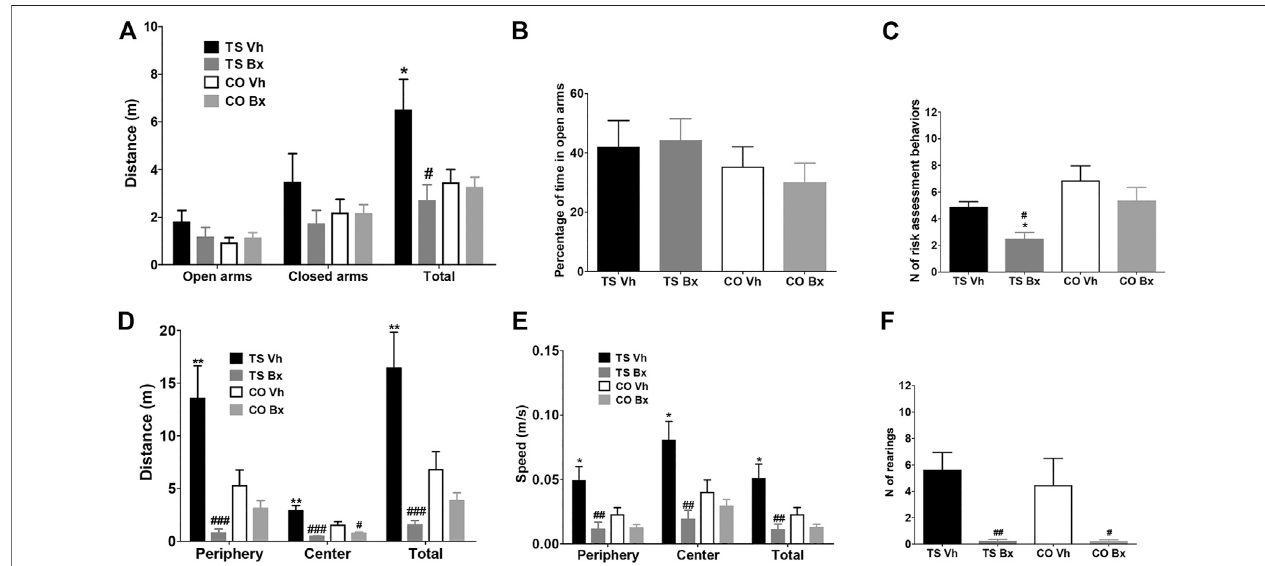
FIGURE3| Mean ± S.E.M.ofthedistancetraveledintheopenandclosedarms,andofthetotaldistance (A) ,ofthepercentage oftimespentintheopenarms (B) , and of the number of risk assessment behaviors (C) , performed by the four groups of mice in the Plus maze; and of the total distance traveled during the open fi eld test (D) , of the speed displayed in the different areas of the apparatus, and the mean speed during the test (E) , and of the total number of rearings (F) , performed by the four groupsofmice.*: p < 0.05;**: p < 0.01TSVhvs.COVh,orTSBxvs.COBx;#: p < 0.05,##: p < 0.01;###: p < 0.001TSBxvs.TSVh,orCOBxvs.COVh.Fisher ’ s LSD post-hoc